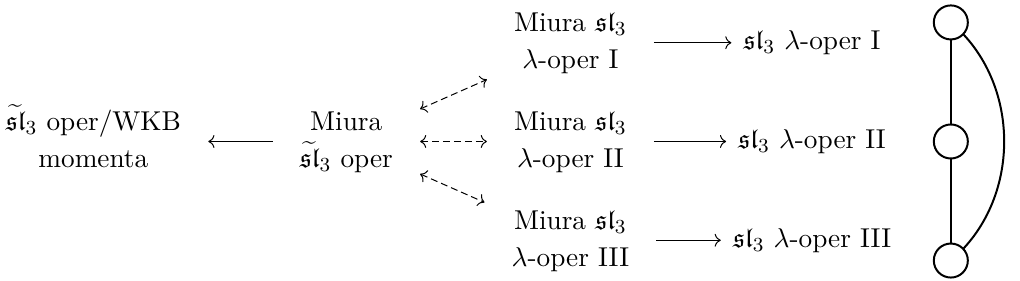
Figure 3 . The three different types of (Miura) sl 3 λ -opers, labelled I, II and III, associated with the three nodes of the Dynkin diagram of e sl the WKB momenta of the third order differential operator